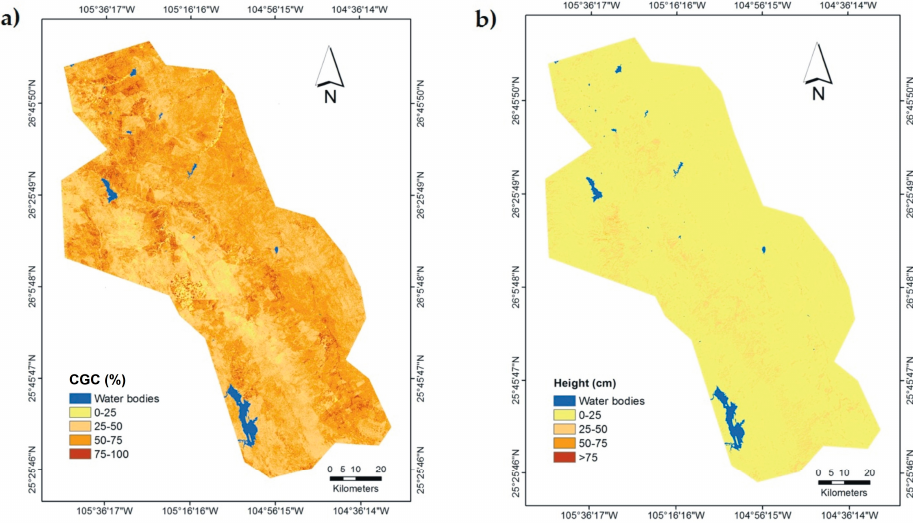
Figure 4. ( a ) Coverage of grass canopy (CGC) and ( b ) grass height distributions for 2009.